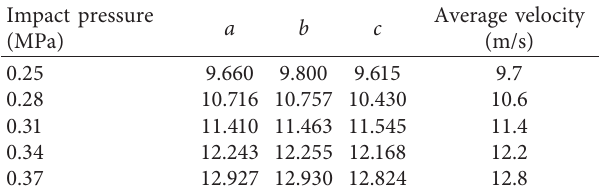
Table 1: Impact velocity under different impact pressures (m/s). Impact